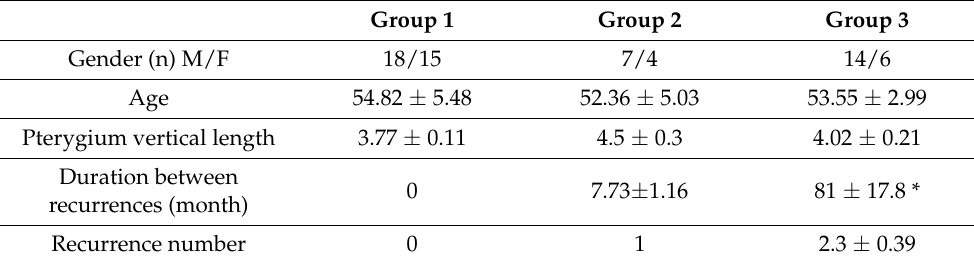
Table 1. Demographic features. * p < 0.05 compared to group 2. ‘n’ denotes number of patients.